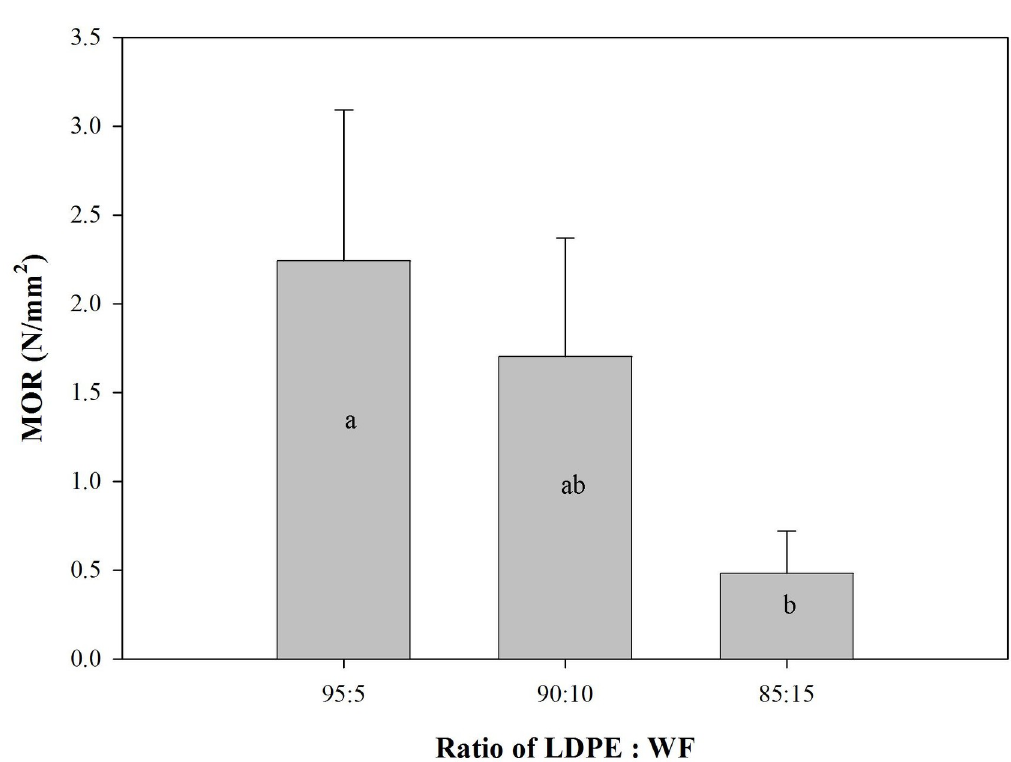
Fig 7. MOR of predominantly plastic WPC (Different letter upper the bars are statistically different according to the DMRT at α = 0.05).